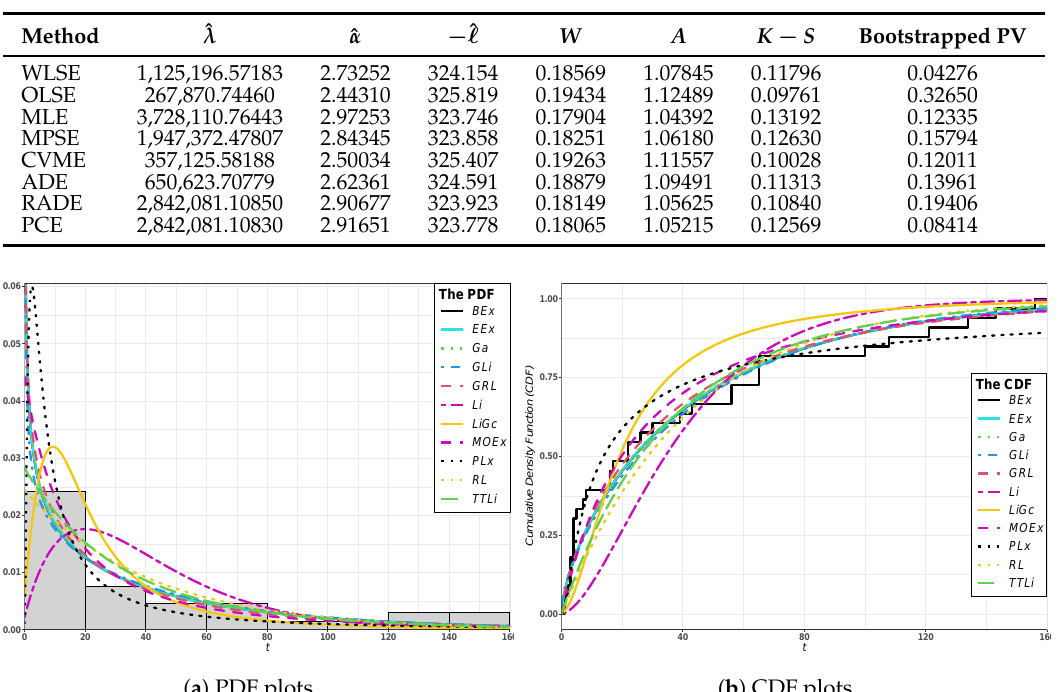
Table 15. The parameter estimates under various estimation methods, including K − S and bootstrapped PV for epicenter data.